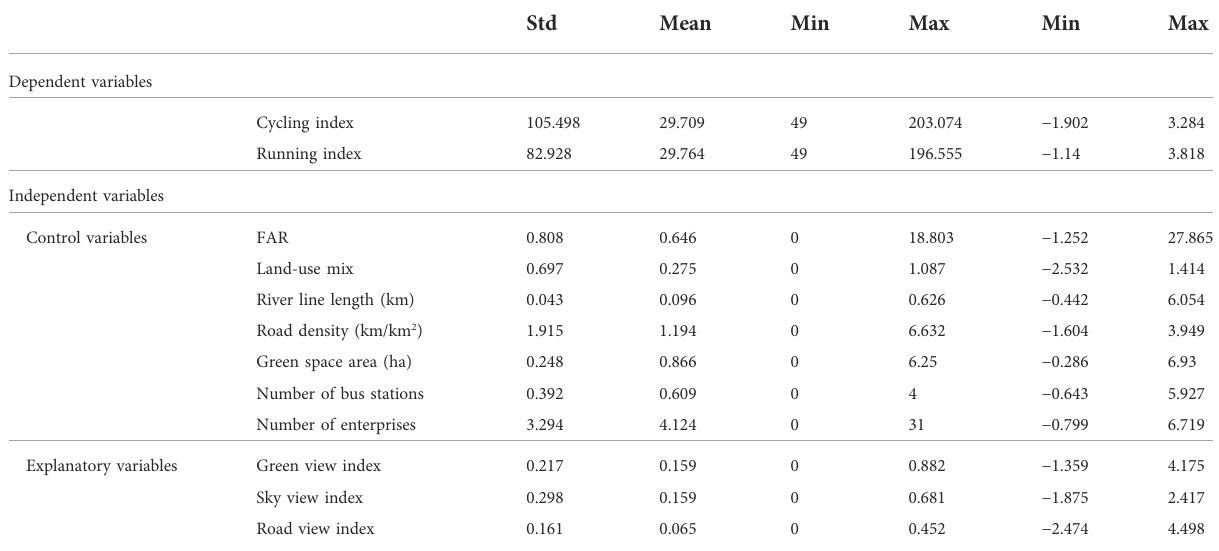
TABLE 2 Descriptive statistics of the variables.